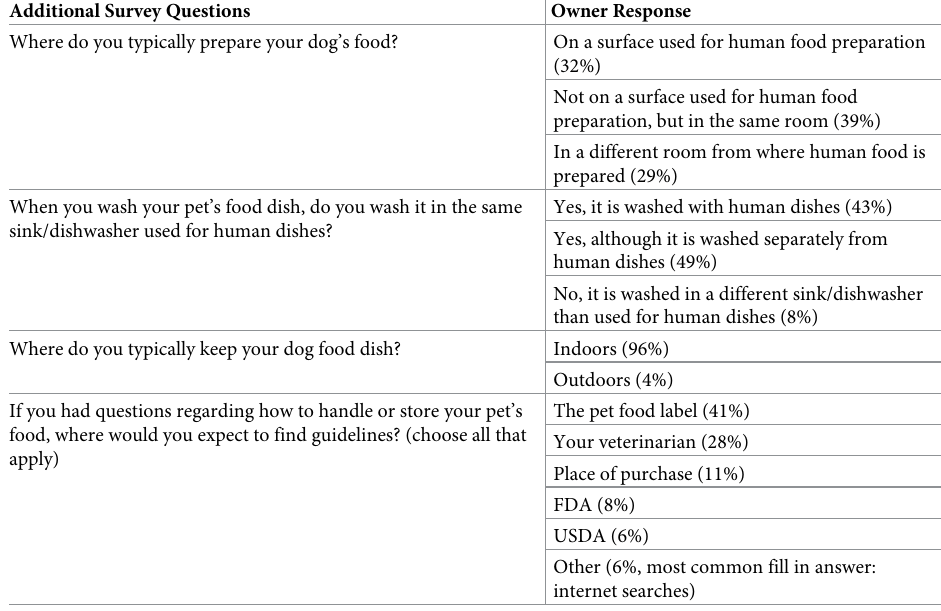
Table 2. Additional survey questions.